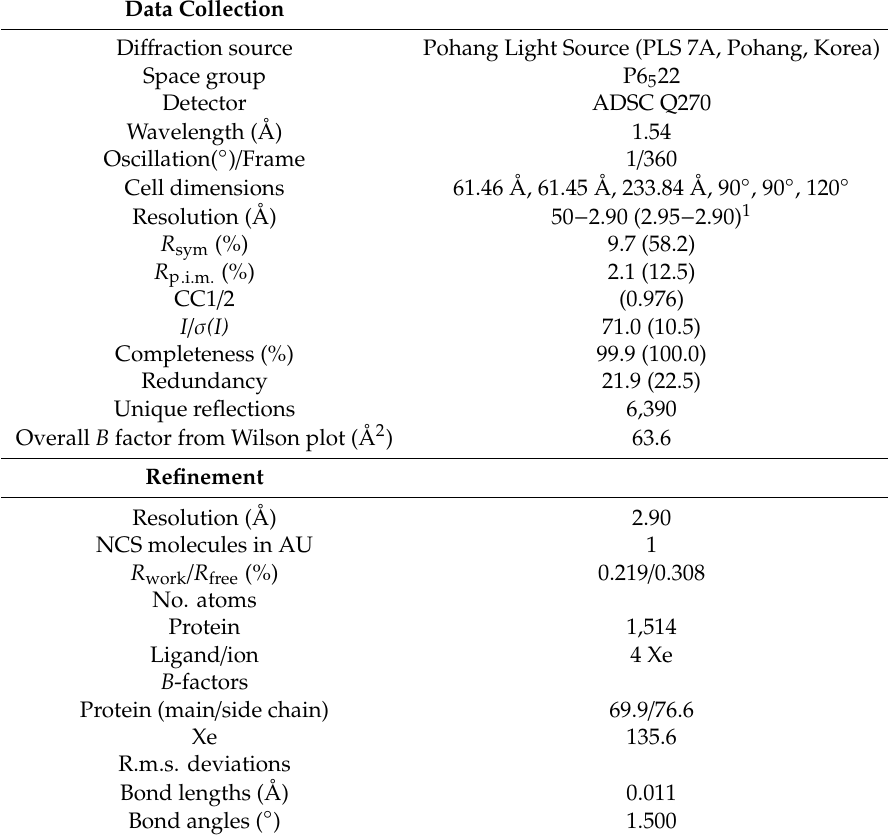
Table 1. Data collection and refinement